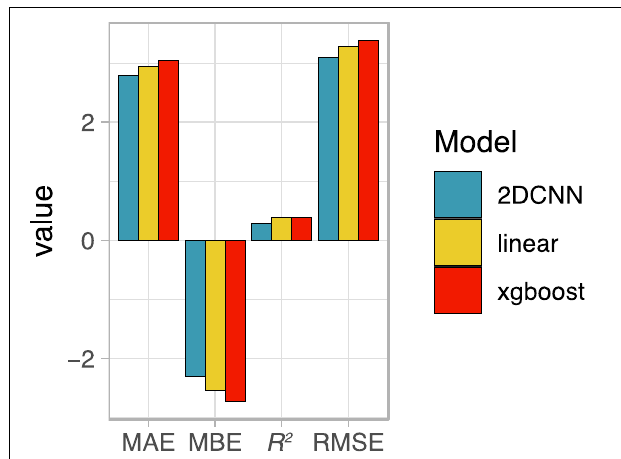
FIGURE 6 | Average performance of late booting stage models from 2019, evaluated on a separate nearby field in the 2020 growing season. MAE, mean absolute error; MBE, mean bian error; R 2 , coefficient of determination; RMSE, root mean squared error; 2DCNN, two-dimensional convolutional neural network.